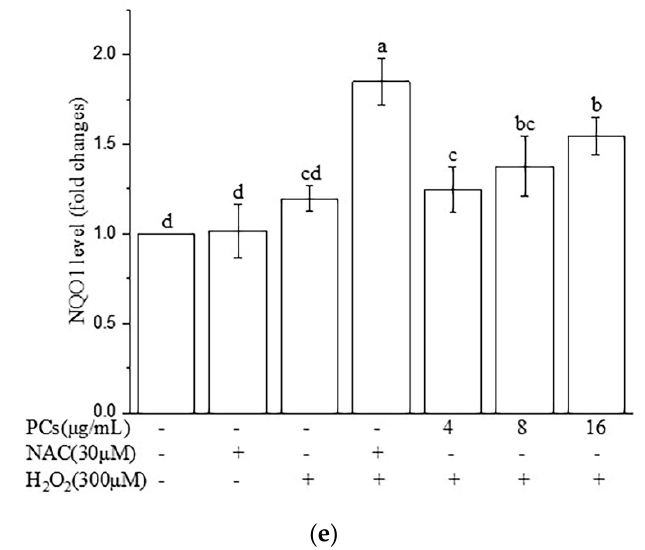
Figure 7. Effects of PCs on the Nrf2/ARE pathway in H 2 O 2 -treated zebrafish larvae. ( a ) Nrf2 levels; ( b ) GCLC levels; ( c ) GCLM levels; ( d ) HO-1 levels; ( e ) NQO1 levels. Data are expressed as the mean ± SD. Values with different letters above are significantly different ( p < 0.05, one-way ANOVA test).